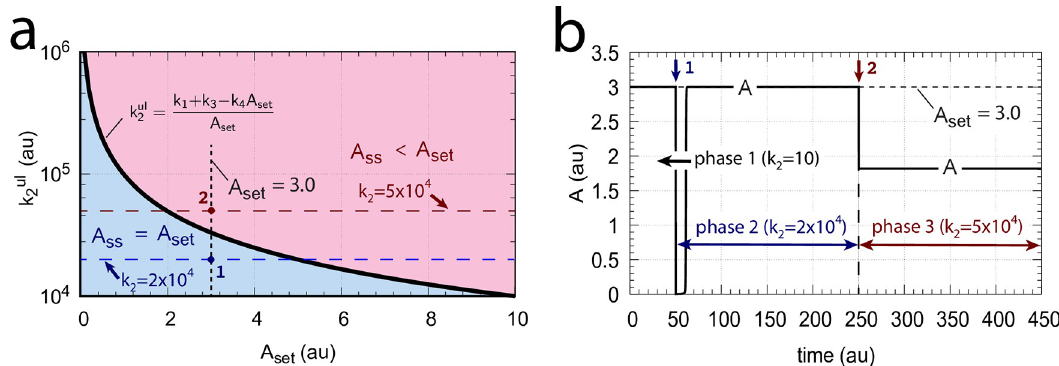
Fig 21. Operational range of m4 controller with upper defendable limit of k 2 ( k ul = k 1 + k 3 − k 4 A / A ). (a) Blue area indicates the set set 2 range as a function of A in which the controller can defend A . Black solid curve: k ul as a function of A when k 1 =0.0, k 2 < k ul set set set 2 2 where A is lower than A . (b) Computation showing the partial loss of homeostasis when k 3 =1 × 10 5 , and k 4 =1.0. Red area: k 2 > k ul ss set 2 . Phase 1 (0–50 time units): k 2 =10; phase 2 (50–250 time units): k 2 =2 × 10 4 ; phase 3 (250–450 time units): k 2 becomes larger than k ul 2 k 2 =5 × 10 4 . Other rate constants and initial conditions as in Fig 20. For further descriptions, see S1 Text.